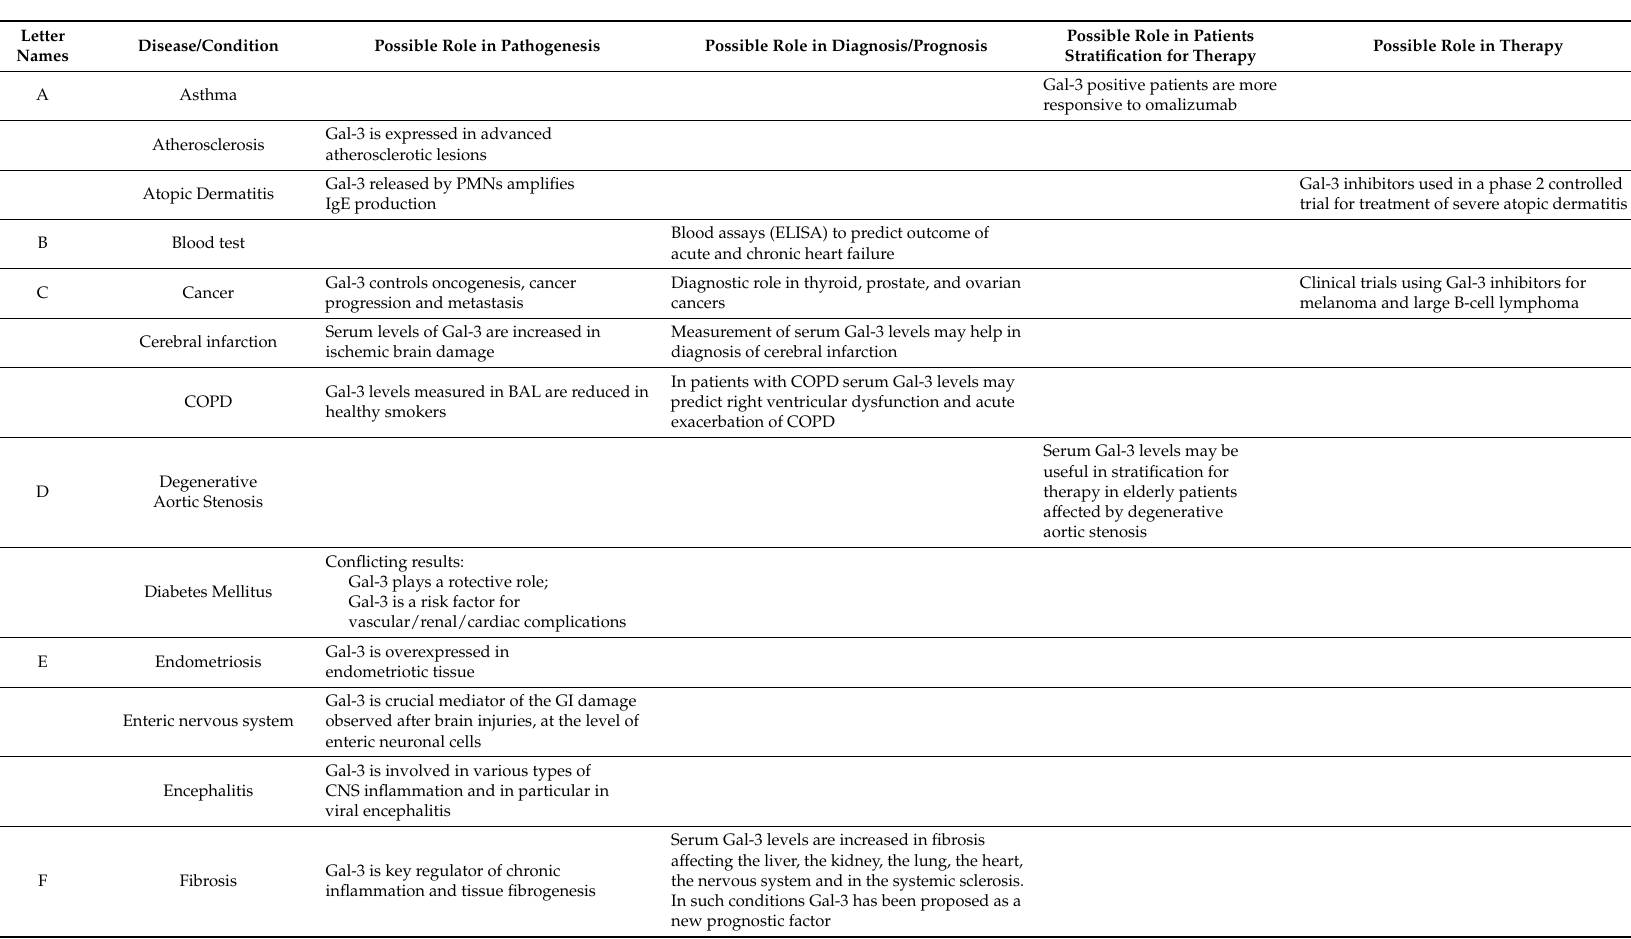
Table 1. Conditions and diseases, listed in alphabetical order, in which a possible role of Gal-3 was postulated in pathogenesis, diagnosis, prognosis, stratification for therapy and in